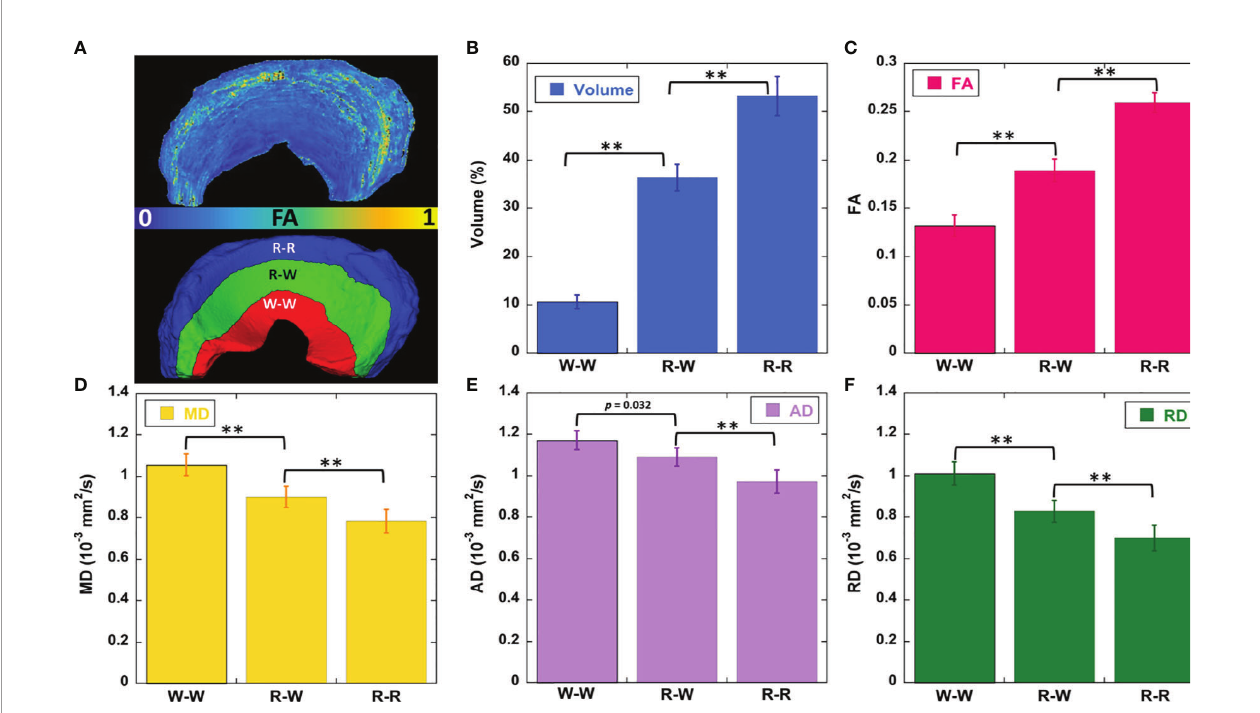
FIGURE 2 | The FA and segmentation 3D rendering images (A) , volume (B) , DTI metrics of FA (C) , mean diffusivity (D) , axial diffusivity (E) , and radial diffusivity (F) values at different zones. FA value gradually decreases from R-R to W-W zone (C) . The diffusivity metrics exhibit the opposite trends (D – F) . ** stands for p -value <0.001. R-R, Red-Red zone; R-W, Red-White zone; W-W, White-White